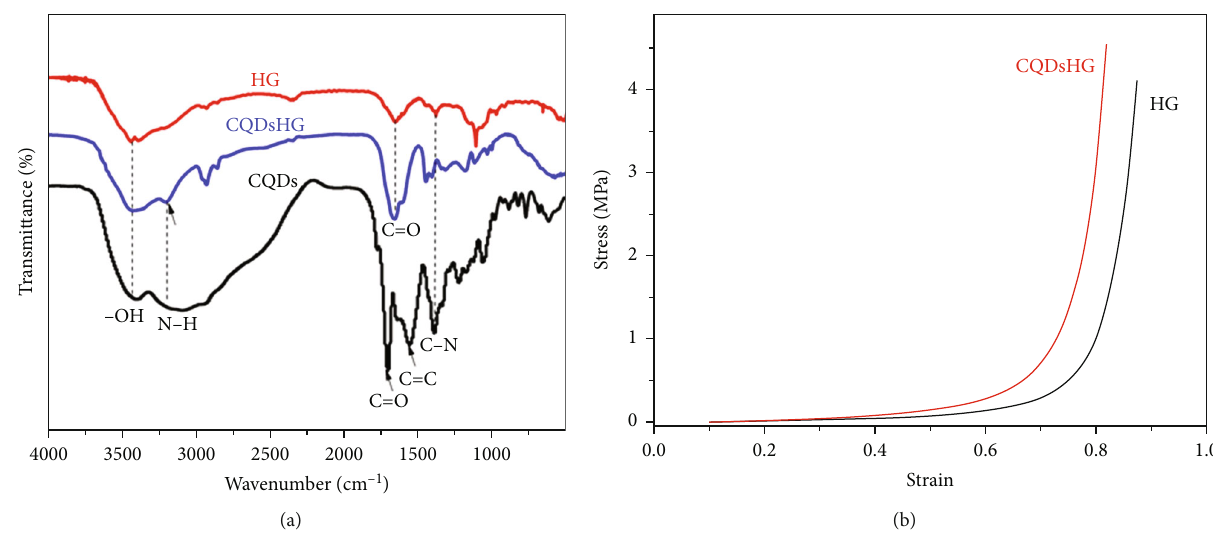
Figure 4: (a) FTIR spectra of the CQDs, HG, and CQDsHG, (b) compressive test of the HG and